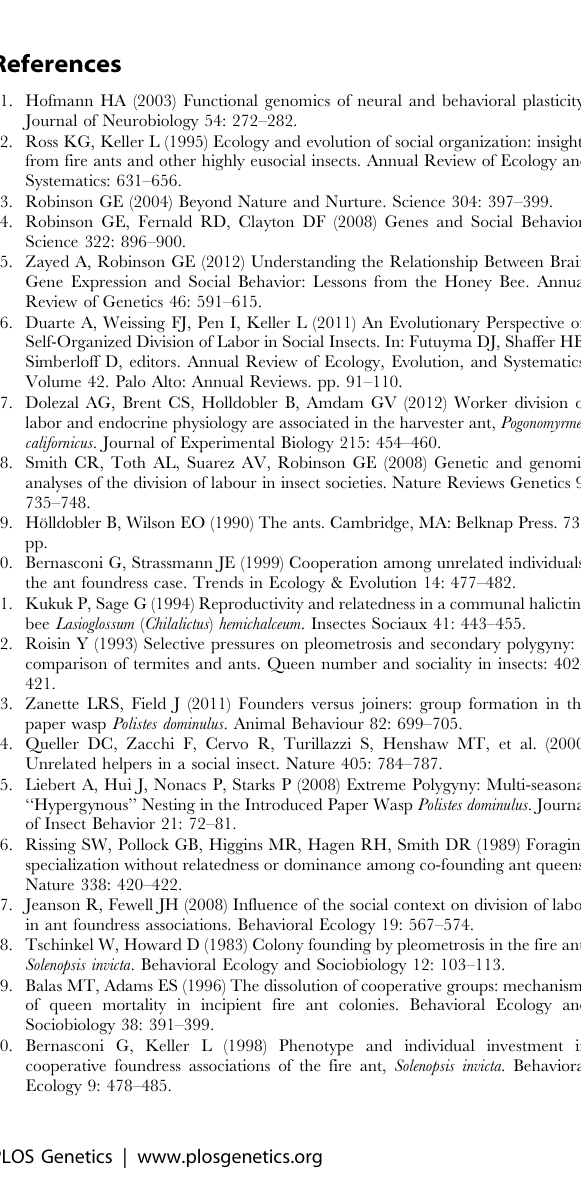
Table S8 Experiment 1, cluster 1: significantly enriched KEGG pathways and GO terms that were used in the analyses with the cateGOrizer ‘‘Immune system gene classes’’ (Functional Annota- tion Chart, P , 0.05). Table S9 Experiment 1, cluster 2: significantly enriched KEGG pathways and GO terms that were used in the analyses with the cateGOrizer ‘‘Immune system gene classes’’ (Functional Annota- tion Chart, P , 0.05). Table S10 Quantitative real-time PCR validation of expression levels of genes of interest from experiment 1: gene lists and primers’ sequences. Table S11 Experiment 2: significantly differentially regulated transcripts (P , 0.1). (XLSX) Table S12 Experiment 2: significantly enriched GO terms (Functional Annotation Clustering, medium stringency, P , 0.05). (XLSX)